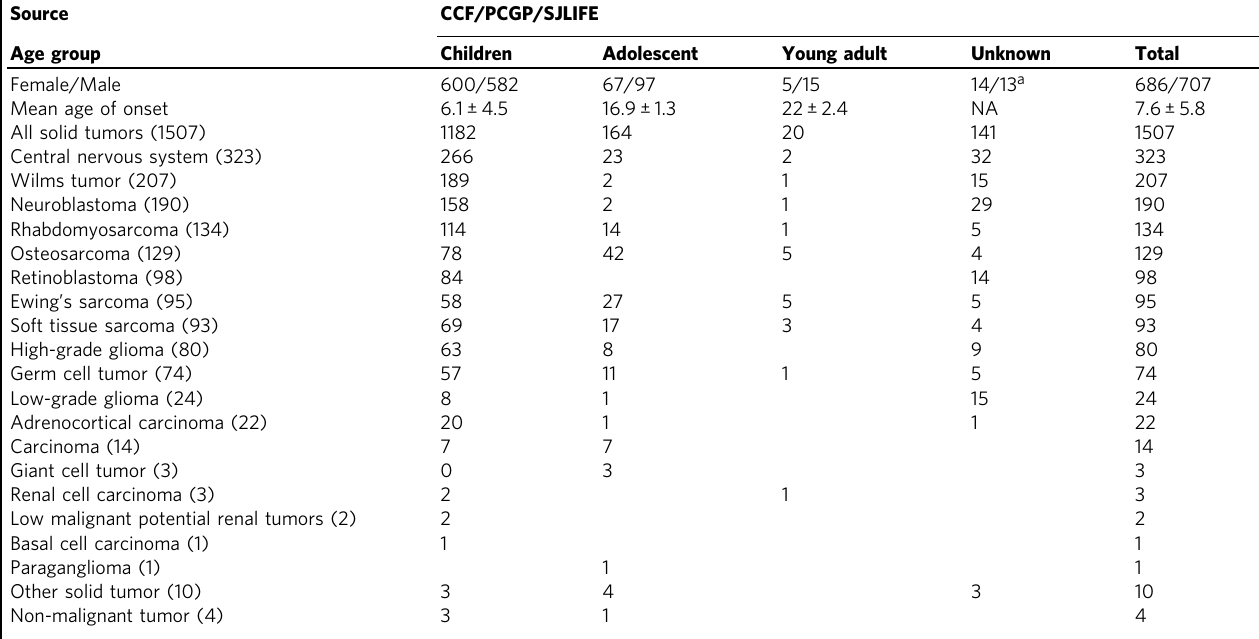
Table 2 Demographics and clinical characteristics of